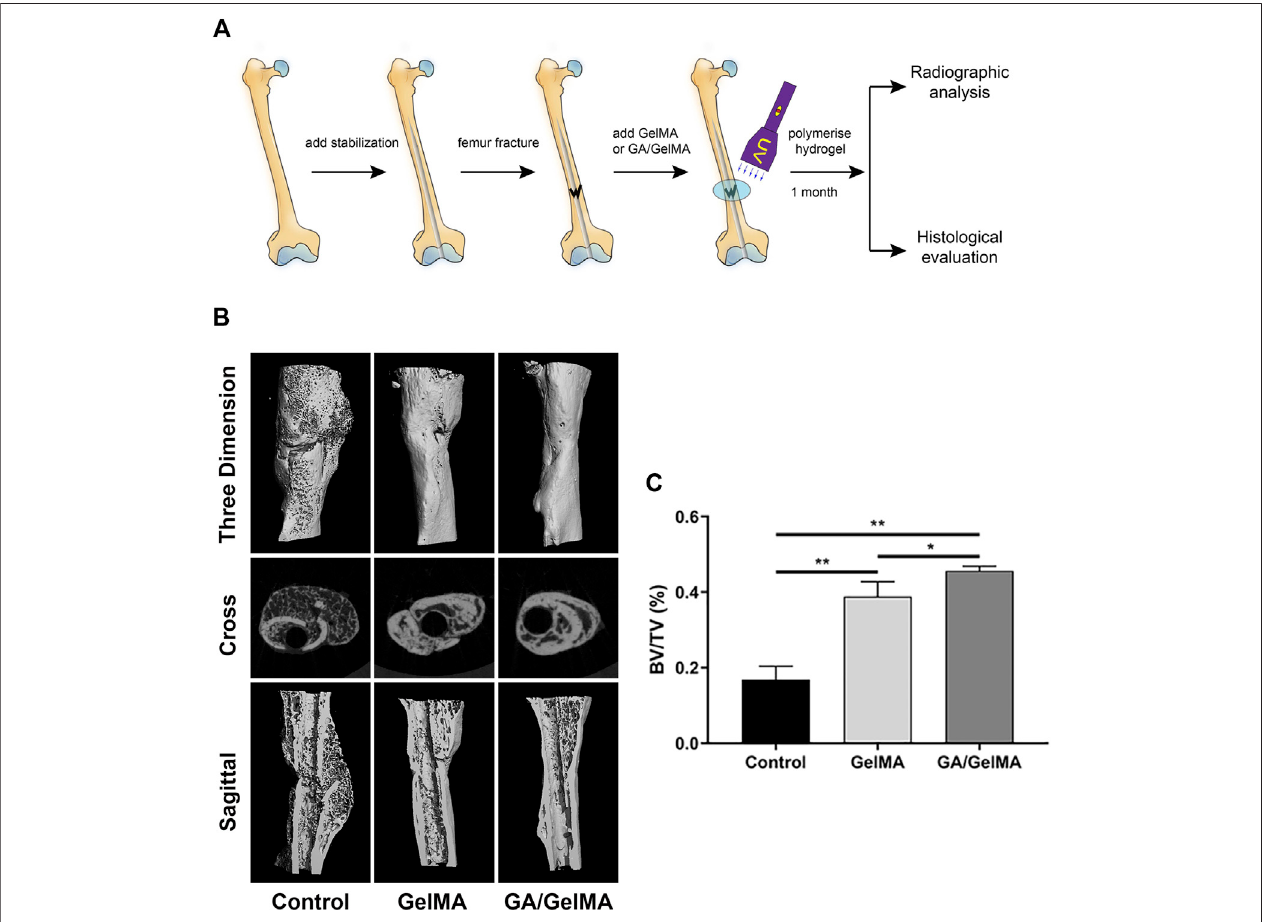
FIGURE6| GA/GelMAhydrogelsacceleratedbonehealinginamousefemoralfracturemodel. (A) Schematicdiagramofmousefemoralfracturemodel. (B) Micro- CT analysis of bone fracture healing. (C) Trabecular bone volume fraction (BV/TV) were analyzed by micro-CT. All experiments were performed in triplicate. Data are expressed as means ± SD. * p < 0.05 and ** p < 0.01 between two groups.